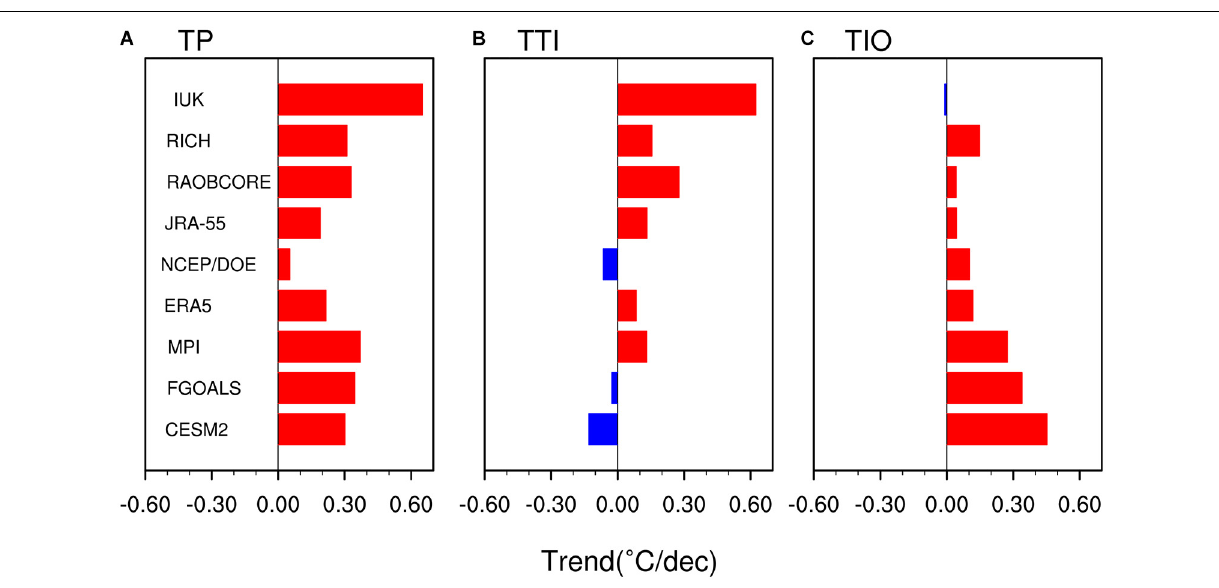
FIGURE 4 | The trends for the (B) TTI and (A,C) the summer temperature at 400–200 hPa in the troposphere for TP and TIO, respectively ( ◦